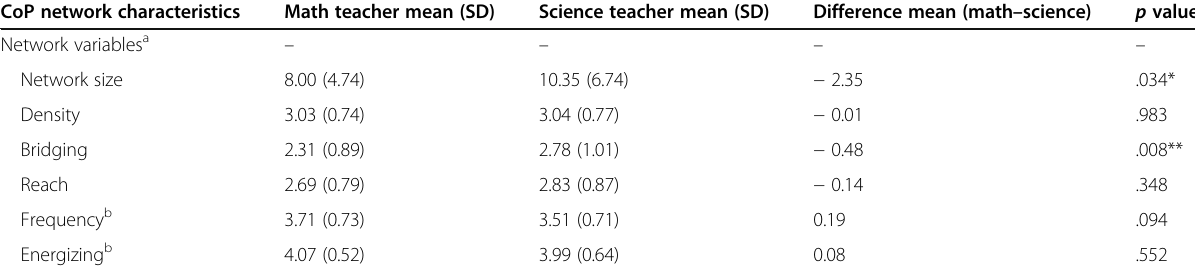
Table 3 Differences in science and math teacher CoP network characteristics by the mean CoP network characteristics